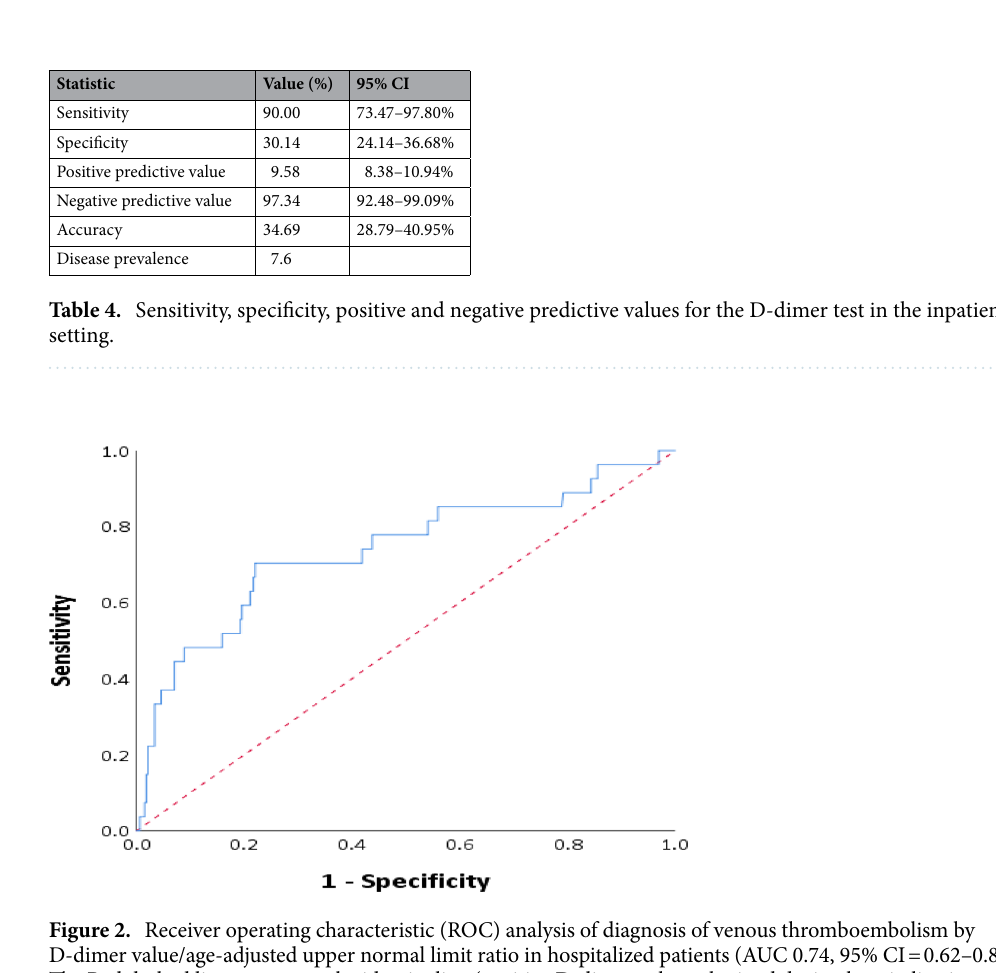
Table 3. Multivariable logistic regression of venous thromboembolism during hospitalization or within 3 months of discharge.